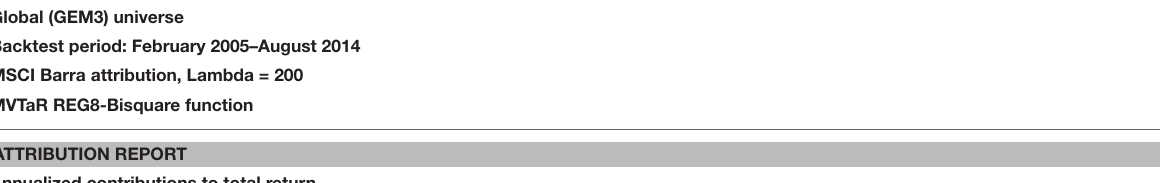
TABLE 2 | Barra attribution of regression-based